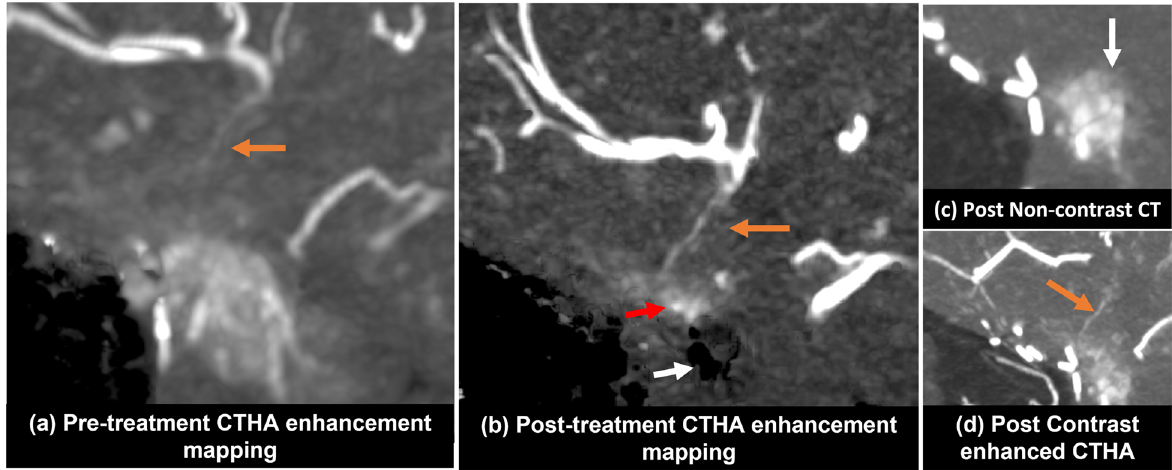
Fig. 5 An example illustrating how to identify feeding arteries on CTHA‑EM with residual tumor enhancement. a Before DEB‑TACE, a small feeding artery (orange arrow) could be barely depicted on pre‑treatment imaging. b After DEB‑TACE, this feeding artery became prominent (orange arrow) with residual tumor enhancement (red arrow) on posttreatment CTHA‑EM image. A region of contrast stasis could be seen as a subtracted void area (white arrow). c Posttreatment native CT depicts contrast deposition from the delivery of DEB‑TACE (white arrow) at the region suspicious for residual tumor enhancement. d Posttreatment CTHA identified a feeding artery (orange arrow) to the area of contrast deposition in c . However, it is not possible to distinguish residual enhancement from stasis without subtraction image. CT, Computed tomography; CTHA , CT hepatic arteriography; CTHA-EM , CTHA enhancement mapping; DEB-TACE , Drug‑eluting beads transarterial